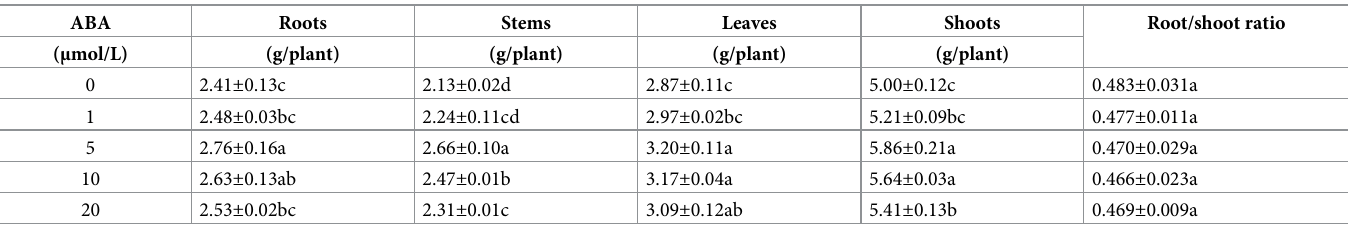
Table 1. Biomass of P . frutescens .